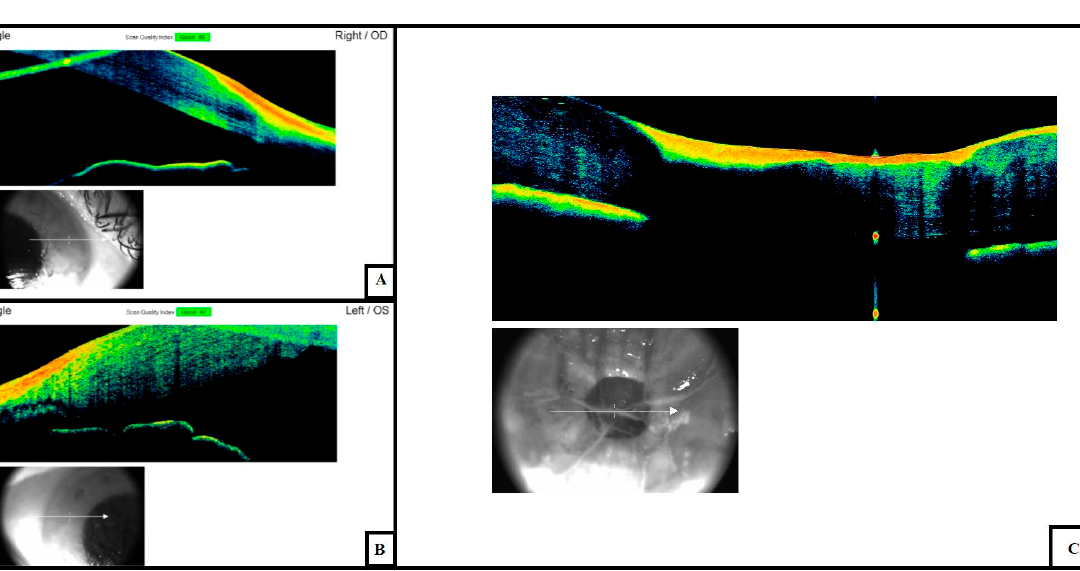
Figure 3. Advanced postmortem interval (36th hour). ( A ) The posterior waving with formation of endothelial humps and an advanced stage of thickening can be seen. ( B ) The figure shows the partial or total loss of the epithelium. ( C ) Macroscopic image of the eye examined in figure 3b. We hypothesized that this finding was due to ultrastructural changes and a progressive decrease in intraocular pressure, as already described by Balci and colleagues. sphericity and abolition of the anterior chamber (Figure 4). leaving the basement membrane exposed.